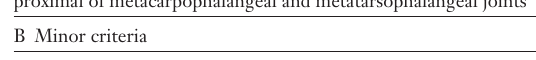
ARA 1980 Classifica- tion Criteria [1].